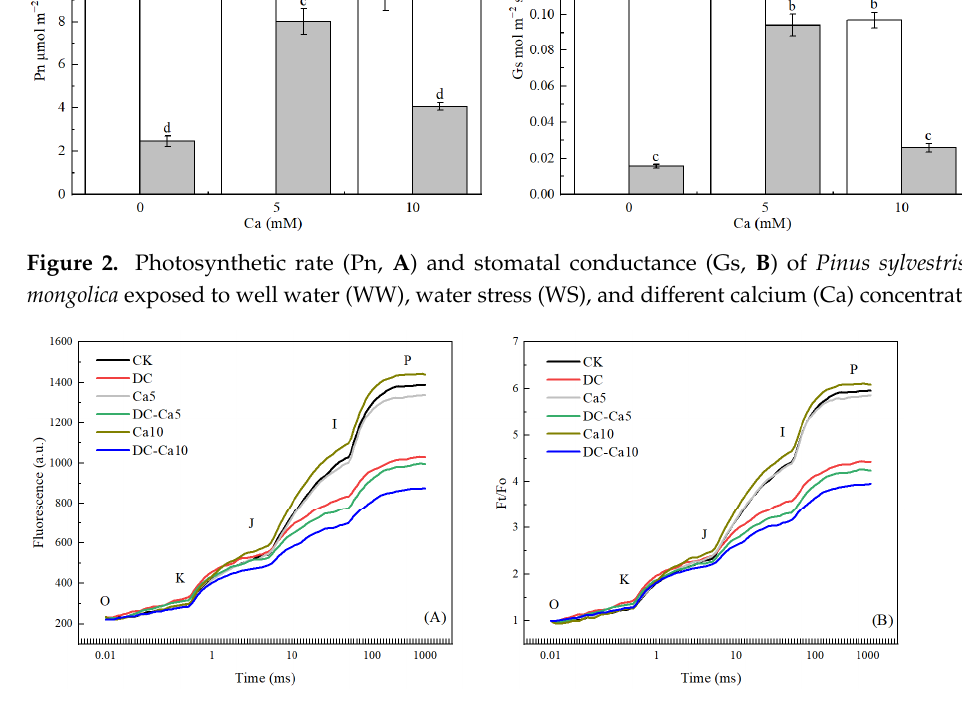
Figure 2. Photosynthetic rate (Pn, A ) and stomatal conductance (Gs, B ) of Pinus sylvestris var . mon- golica exposed to well water (WW), water stress (WS), and different calcium (Ca) concentrations.